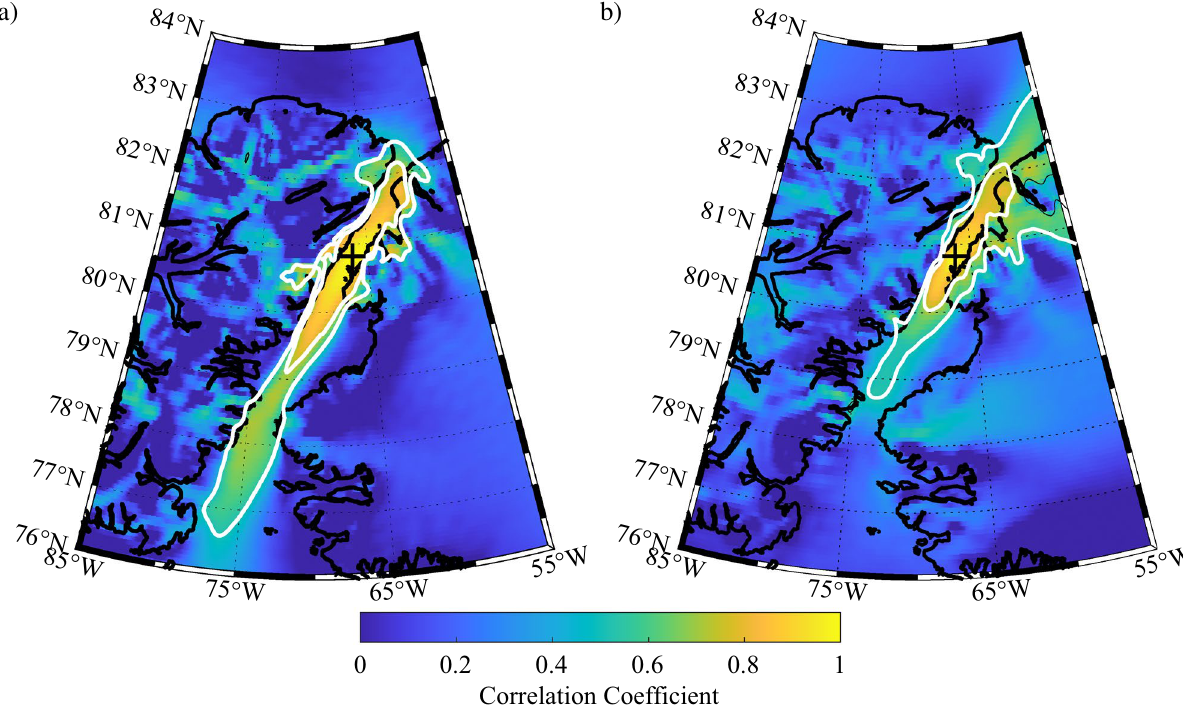
Figure 9. One-point correlation maps showing the correlation between the 10 m wind speed at Hans Island and at other gridpoints in the Nares Strait region as represented in the ECOA. Results are shown for times during the period 2016–2020 during which there was: (a) northerly and (b) southerly flow at Hans Island. The location of Hans Island is indicated by the ‘ + ’. The 0.5 and 0.7 correlation coefficient contours are shown in white. Figure created using Matlab R2019b (https:// www. mathw orks.